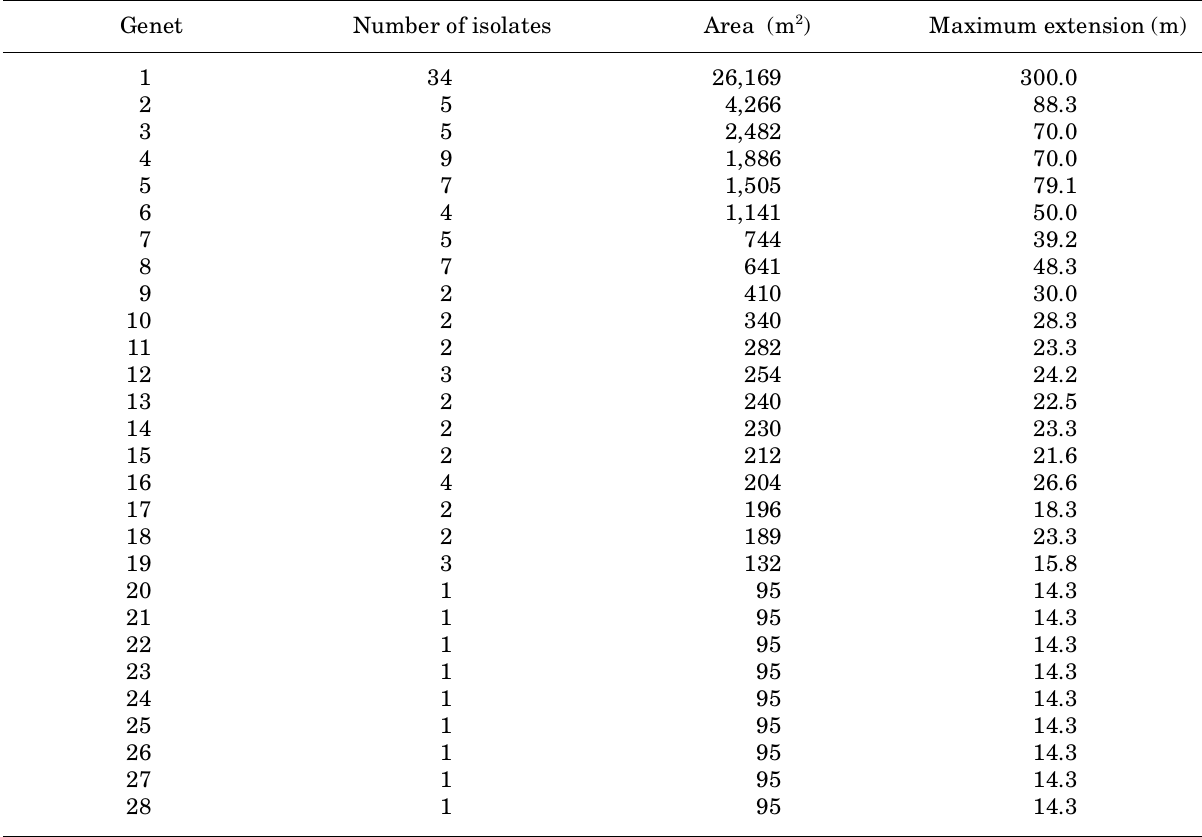
Table 1. Main parameters of the 28 genets of A . gallica detected in the 6.25 ha test site in the Difesa Grande oak wood, Gravina in Puglia, southern